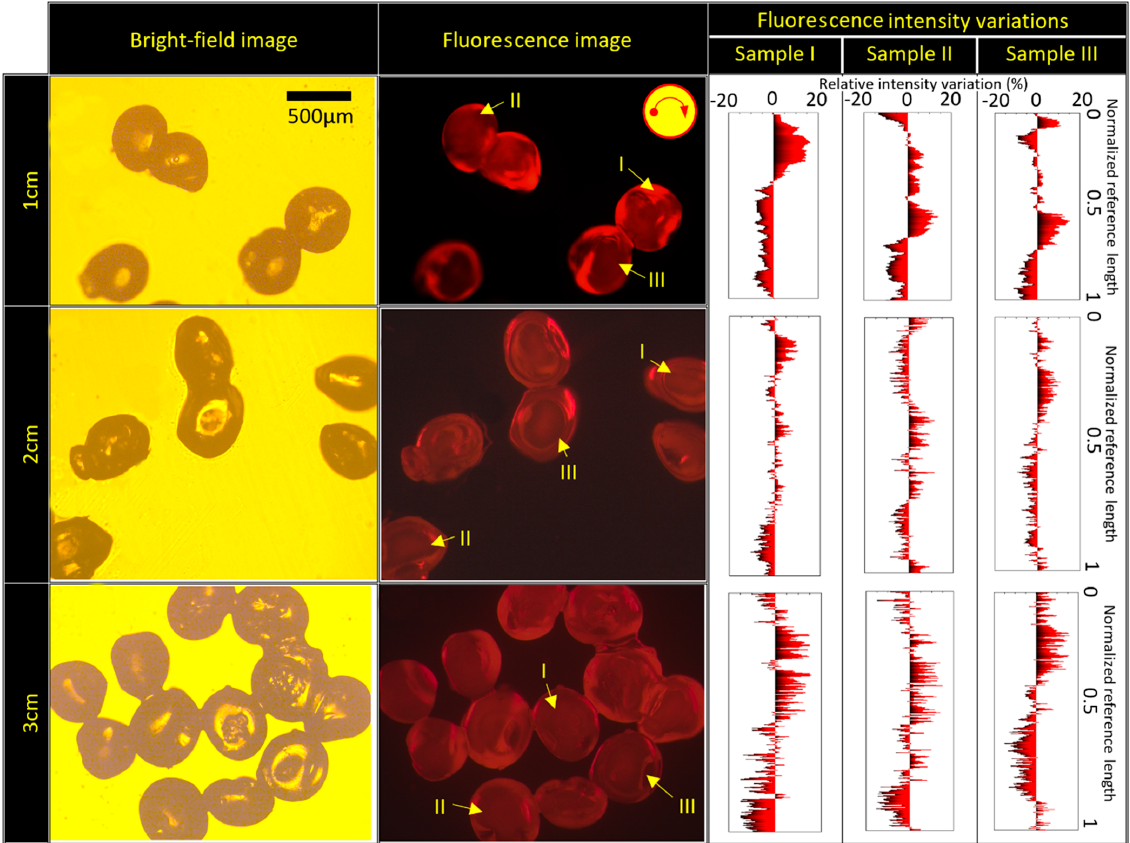
Figure 10. Fluorescence and bright-field images of the generated microparticles using two source fluids with three different fluidic lengths of 1, 2, and 3 cm at f = 50 Hz. Scale bar is 500 µm. Finally, the effect of rotational frequency on the mixing of the two source fluids was investigated. We increased the rotational frequency from 30 to 50 Hz (the maximum motor operating frequency in the set-up) to establish the effects on fluid mixing. Some examples of the bright-field and fluorescence images are shown in Figure 11 using the fluidic barrier length of 2 cm. Relative intensity variation versus the normalized reference length for three samples is shown in the last row in Figure 11. It was seen that, in all generated par- ticles, the fluorescence intensity had a maximum variation of less than 15% compared to the average fluorescence intensity of each particle. This shows that good mixing of two source fluids occurs, even at different rotational frequencies (30 to 50 Hz) due to the sec- ondary internal vortices.